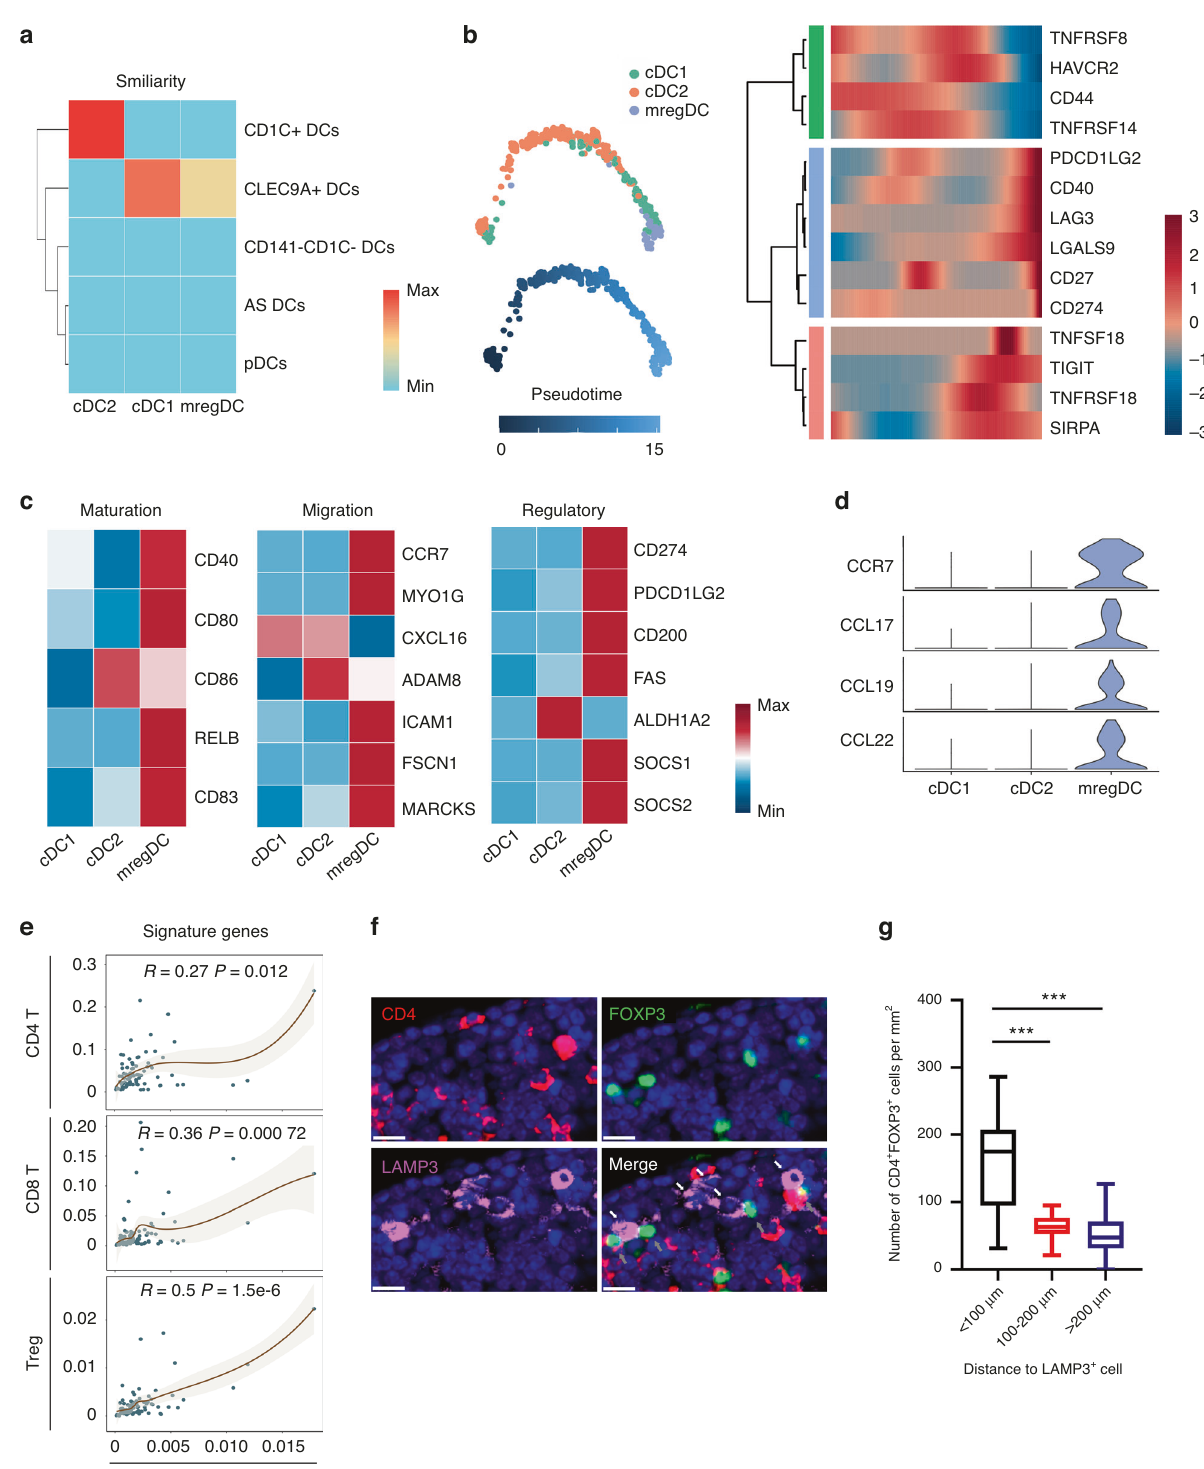
Fig. 3 Mature regulatory dendritic cells (mregDCs) promote tumor immune tolerance. a Heatmap showing the similarity of dendritic cells from the OS scRNA dataset projected onto different dendritic cells identi fi ed from the normal PBMC dataset. Red represents high similarity; blue represents low similarity. b Developmental trajectory for DCs inferred by Monocle2 and the heatmap showing the expression changes of coinhibitors and costimulators along the pseudotime trajectory. c Heatmaps revealing the average gene expression levels of maturation genes, regulatory markers, and migration genes in dendritic cells. Red represents high expression; blue represents low expression. d Violin plots showing the expression of CCR7, CCL17, CCL19 and CCL22 in dendritic cells. e Correlation between the mregDC signature and T-cell signatures in the TARGET OS cohort. f Representative image of mregDCs and regulatory T cells (Tregs) that colocalized in OS tissues stained by multicolored immuno fl uorescence staining. White arrows depict mregDCs, while gray arrows indicate Tregs. The scale bar represents 10 μ m. g Distribution of CD4 + FOXP3 + cells adjacent or nonadjacent to CD42 mregDCs. Data are the means ± SEMs. * P < 0.05; ** P < 0.01; *** P <